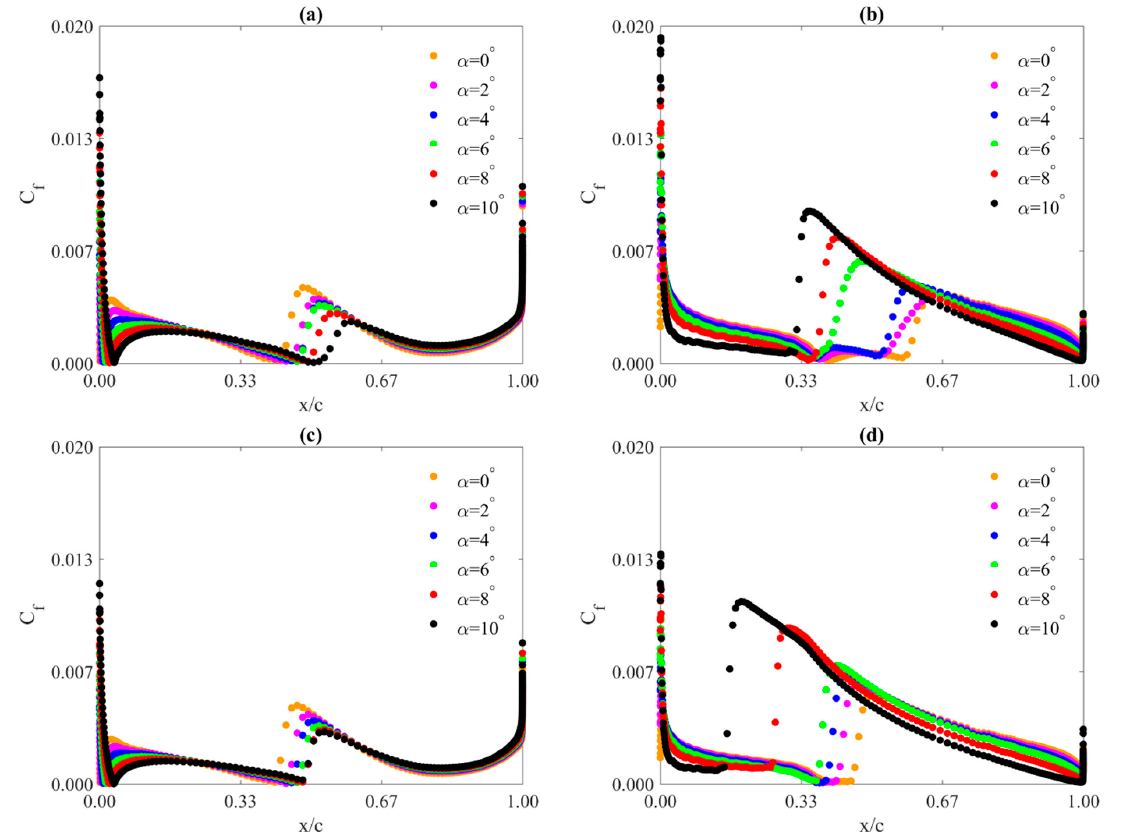
Figure 14. Skin friction coefficient—the effect of the angle of attack for ( a , b ) Re = 3 × 10 6 and ( c , d ) Re = 6 × 10 6 . Moreover, C f for the pressure side of the airfoil are given in ( a , c ), whereas for the suction side of the airfoil are given in ( b , d ). These results are given for URANS with the Transition SST model.